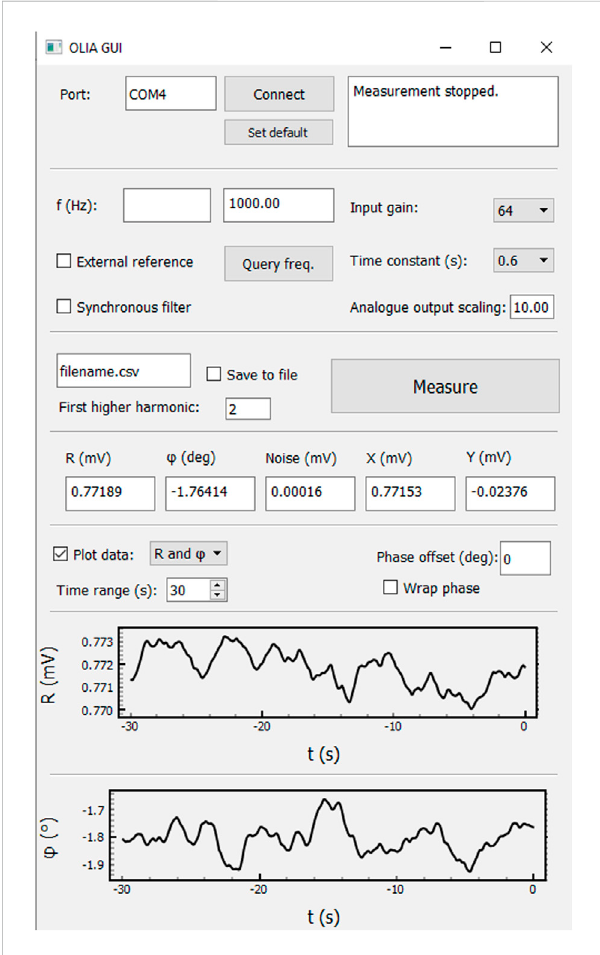
FIGURE 3 Screenshot of Python-based graphical user interface used for controlling OLIA and visualising and saving data. The application window includes controls for connecting to OLIA ’ s serial interface (top), and a text window (top right) for displaying messages relating to the measurement status, e.g., out-of-range signals and connectionstatus.Controlsforsettingmeasurementparameterssuch asthemodulationfrequency,inputgain,timeconstant,andthelowest requested higher harmonic are also present. Two checkboxes are provided for switching between internal or external referencing and low-pass or synchronous fi ltering. A fi le-name may be speci fi ed for live data logging. The numerical values of R 2 , ϕ 2 , X 2 , Y 2 and the noise estimate S 2 are updated every 0.1 s, and the values of R 2 and ϕ 2 or X 2 and Y 2 are plotted in real-time over a speci fi ed time